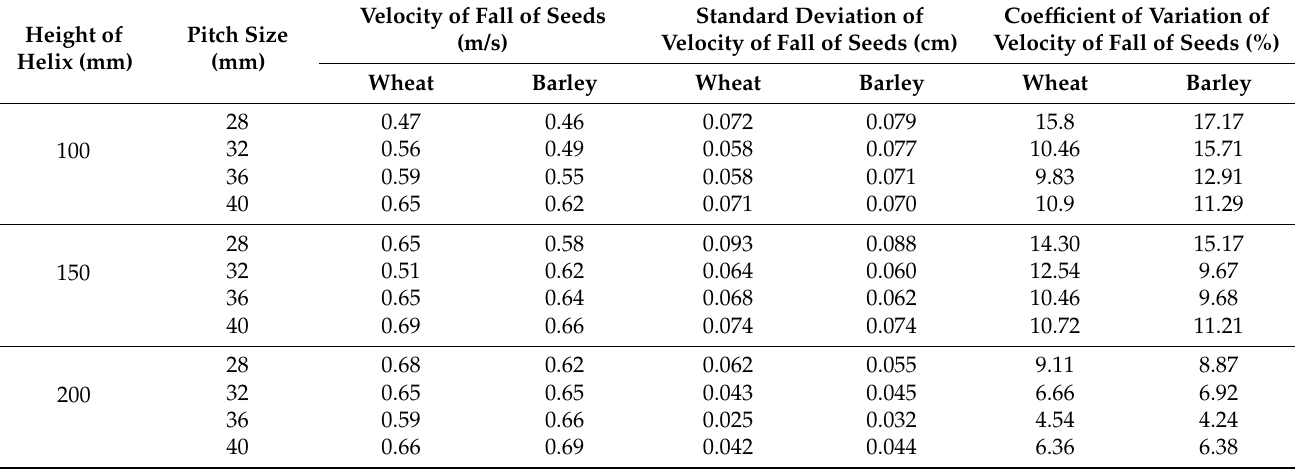
Table 3. The velocity of falling seed in the helicoidal seed tube measured in laboratory tests as influenced by the height of the helix and pitch